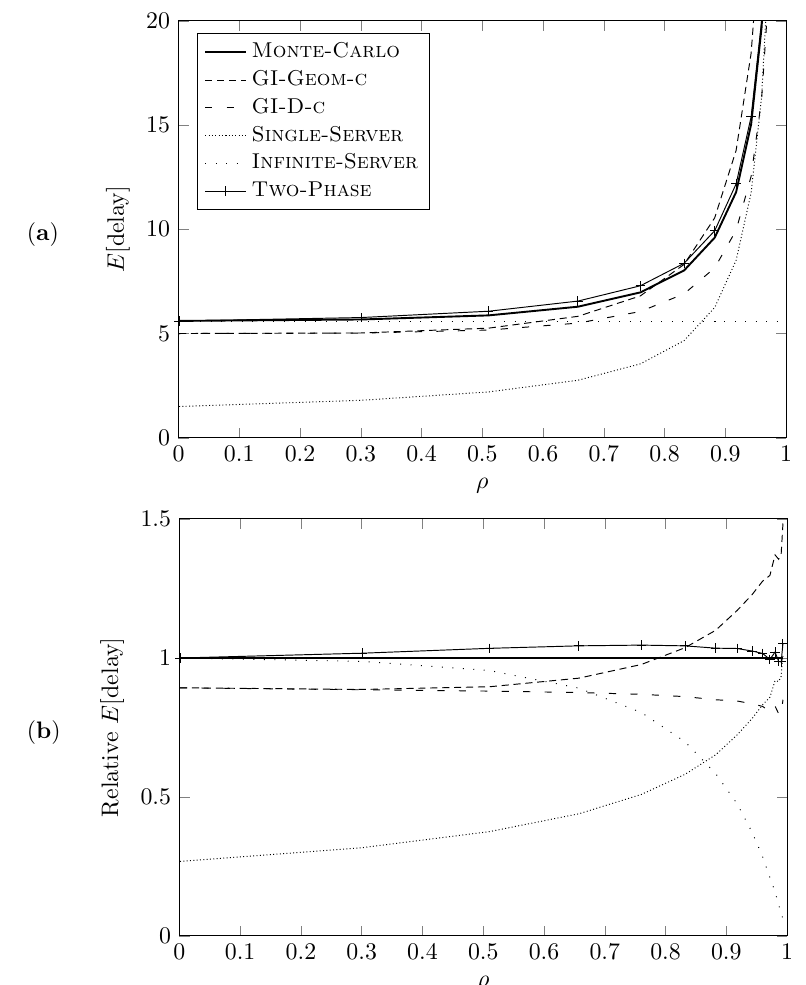
Figure 1. Mean customer delay versus load ρ for a 5-server system with Poisson arrivals, shifted negative-binomial service demands with 5 phases and mean τ = 50, and negative-binomial service capacities with 5 phases and mean µ = 10, as estimated by various approximations, ( a ) in absolute value and ( b ) relative to the M ONTE -C ARLO